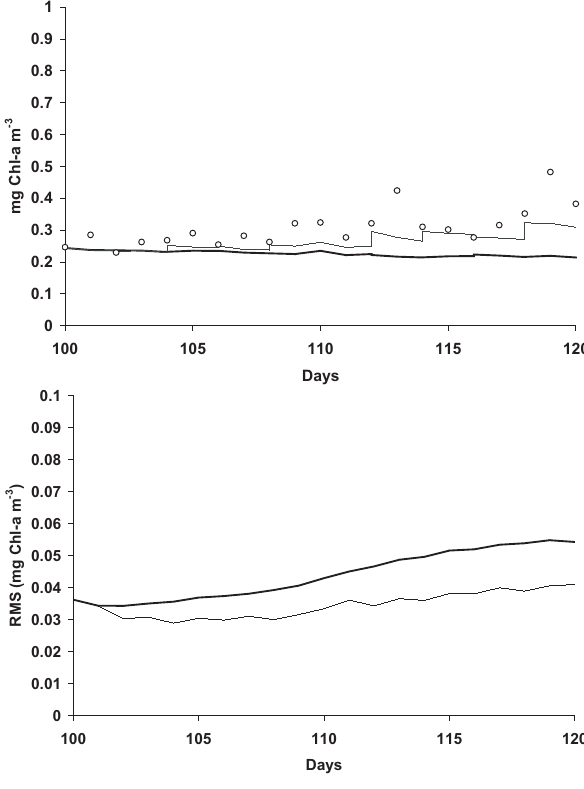
trate ( ) compared with data ( ◦ ), on the chlorophyll simulation at 65m, (b) effect of assimilation of chlorophyll ( ) and nitrate ( ) on the